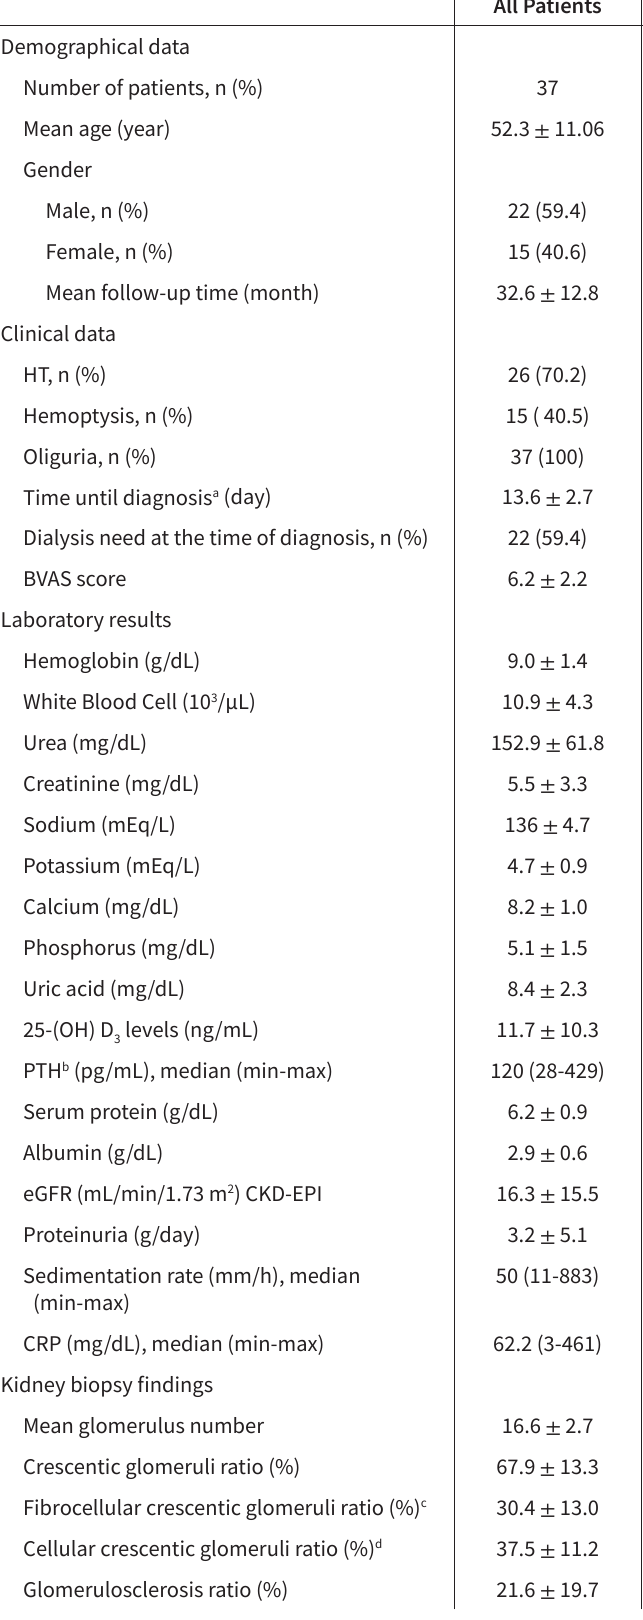
Table 1. Clinical and Pathological Evaluation of Patients with Type 1 and Type 3 RPGN All Patients Anti-GBM c-ANCA p-ANCA